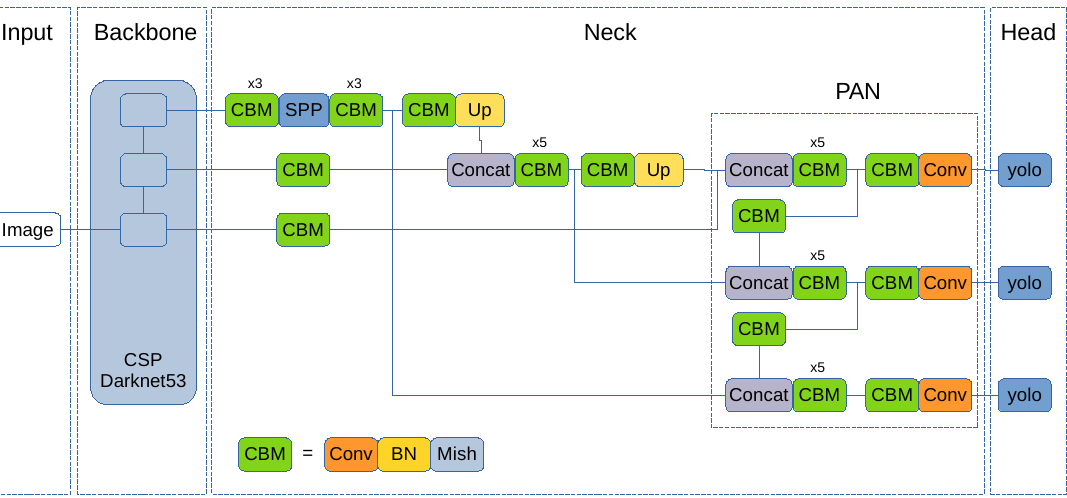
Figure 5. YOLOv4 architecture with all Leaky ReLU functions changed to MISH (Green CBM